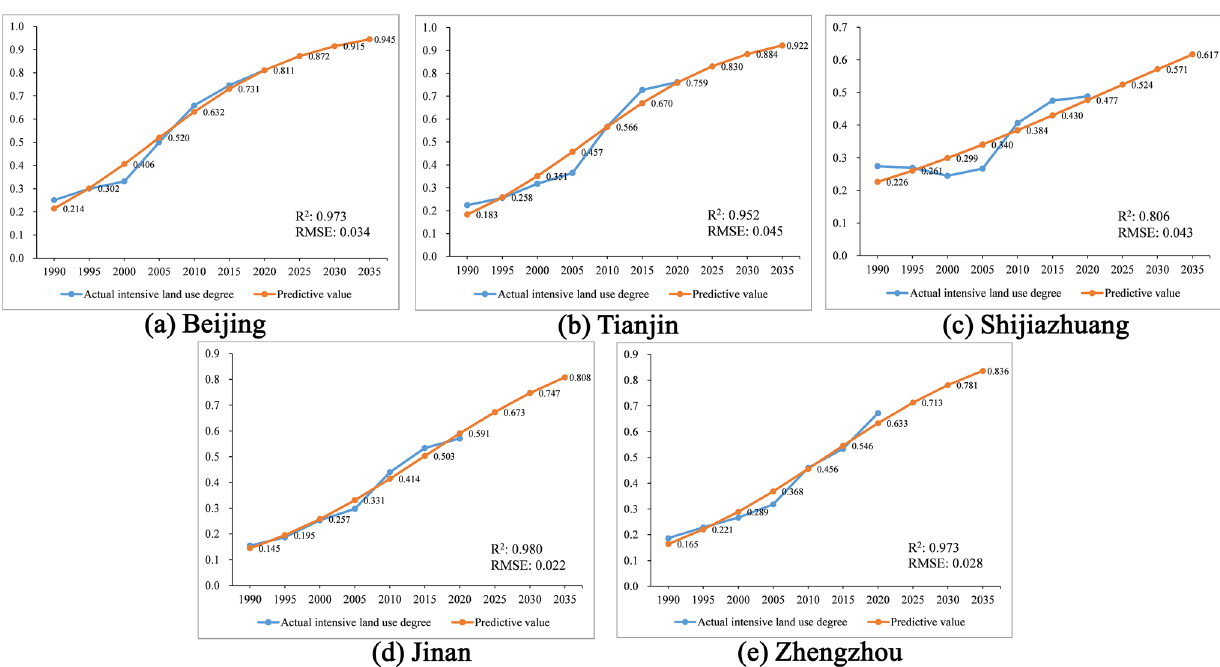
Figure 8. Predictive result of the ILU: ( a ) Beijing; ( b ) Tianjin; ( c ) Shijiazhuang; ( d ) Jinan; ( e )